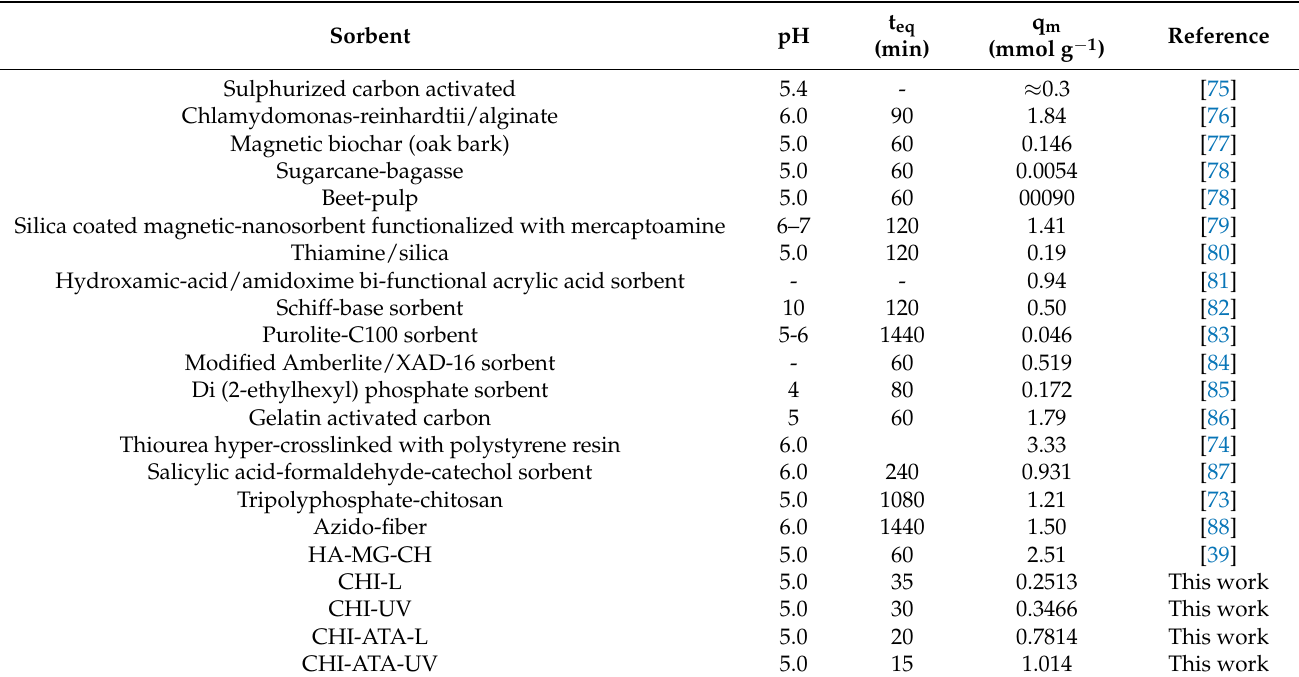
Table 4. Comparison of sorption properties for sorbents (conventional) and